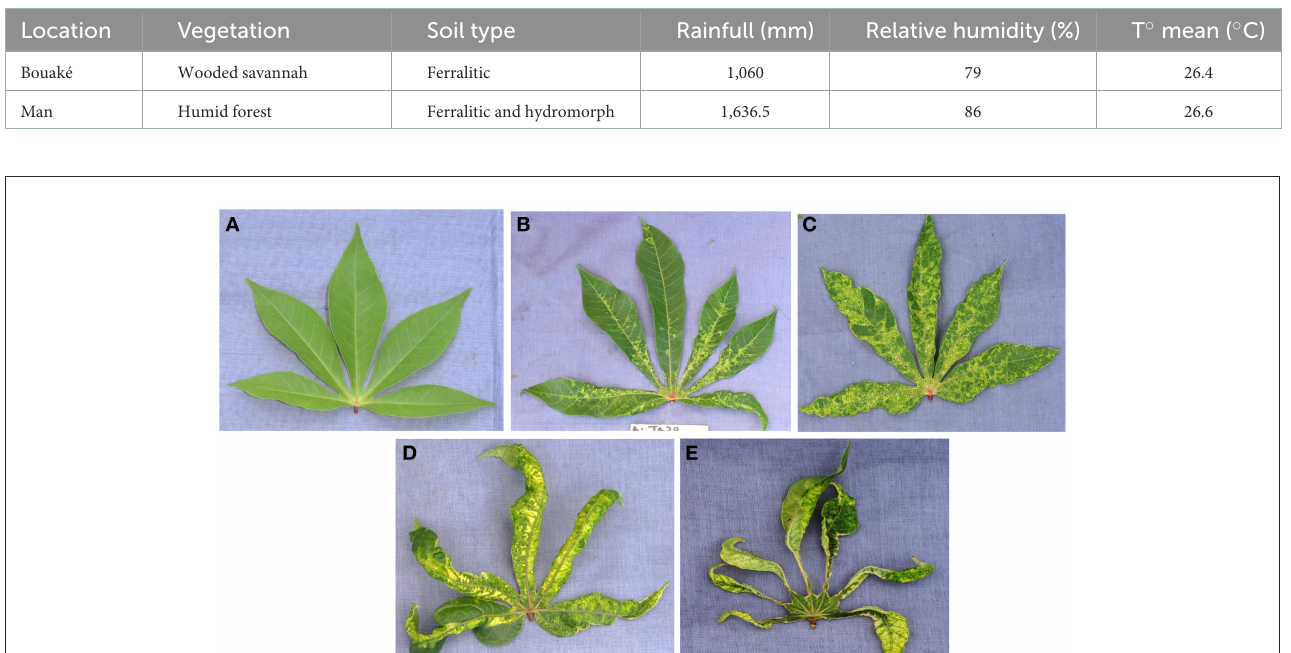
FIGURE1 Symptoms of cassava mosaic disease observed on infected cassava leaves using a scale from 1 (no symptoms) to 5 (very severe symptoms). (A) = 1, (B) = 2, (C) = 3, (D) = 4, (E) = 5.